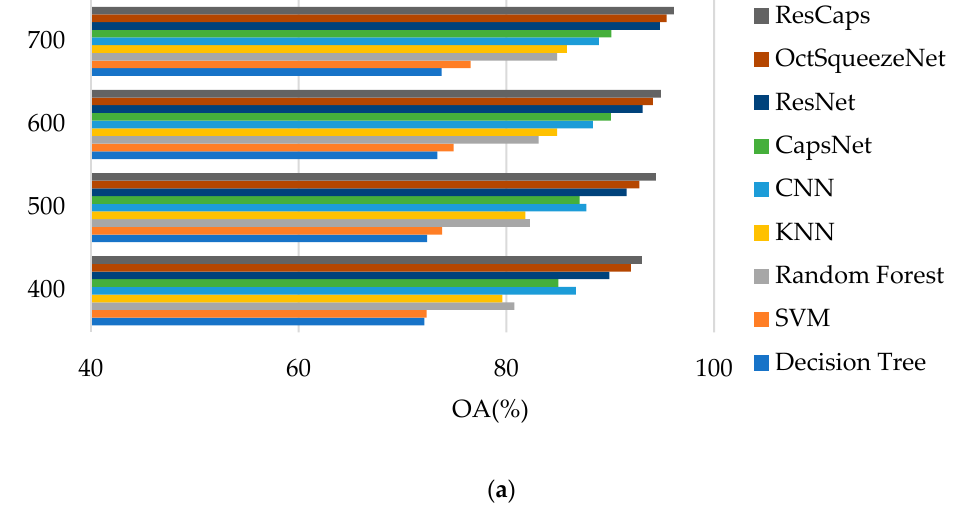
precision Table 5. Precision and recall of each class for 700 samples on Recology data set. Table 5. Precision and recall of each class for 700 samples on Recology data set. Table 5. Precision and recall of each class for 700 samples on Recology data set. Table 5. Precision and recall of each class for 700 samples on Recology data set. Table 5. Precision and recall of each class for 700 samples on Recology data set. Table 5. Precision and recall of each class for 700 samples on Recology data set. Table 5. Precision and recall of each class for 700 samples on Recology data set. Table 5. Precision and recall of each class for 700 samples on Recology data set. Table 5. Precision and recall of each class for 700 samples on Recology data set. Table 5. Precision and recall of each class for 700 samples on Recology data set. Table 5. Precision and recall of each class for 700 samples on Recology data set.